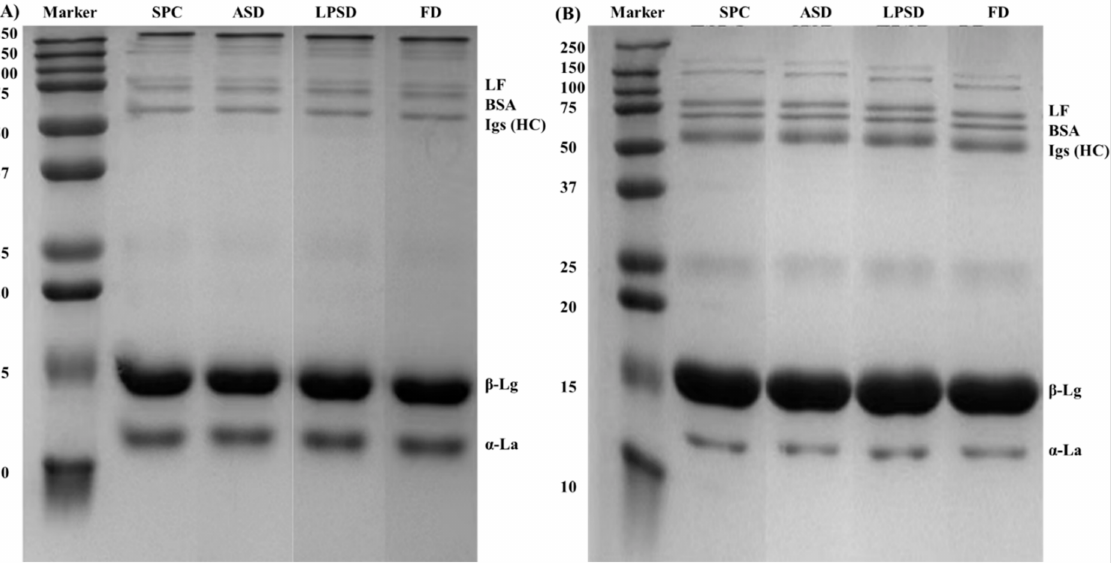
Figure 3. Non-reducing ( A ) and reducing SDS-PAGE ( B ) of serum protein profiles of SPC, ASD, LPSD and